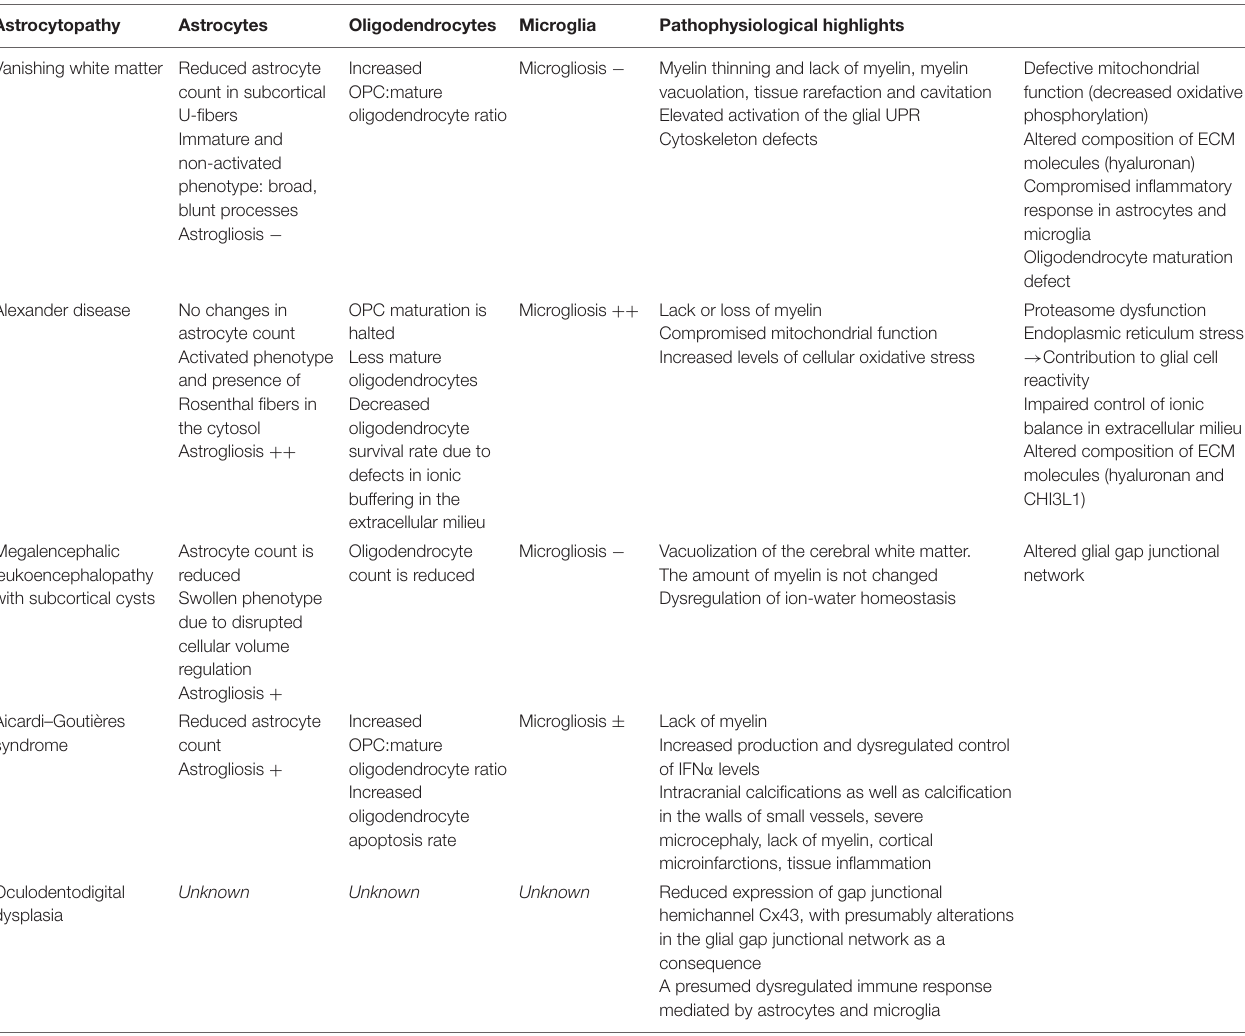
TABLE 1 | Overview of commonalities and differences in the pathophysiology of the various